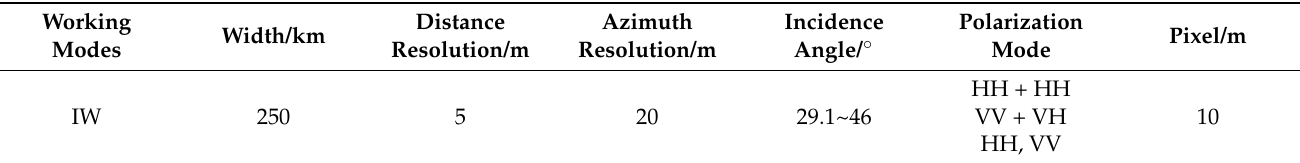
Table 2. The basic parameters of the IW